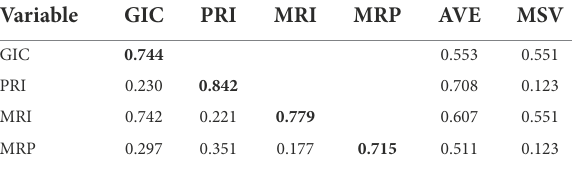
Bold values is square root of AVEs.